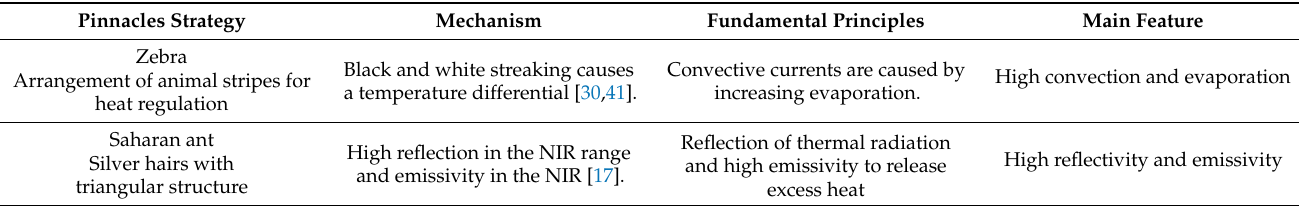
Table 3. Summary of the Pinnacles Analysis. Own